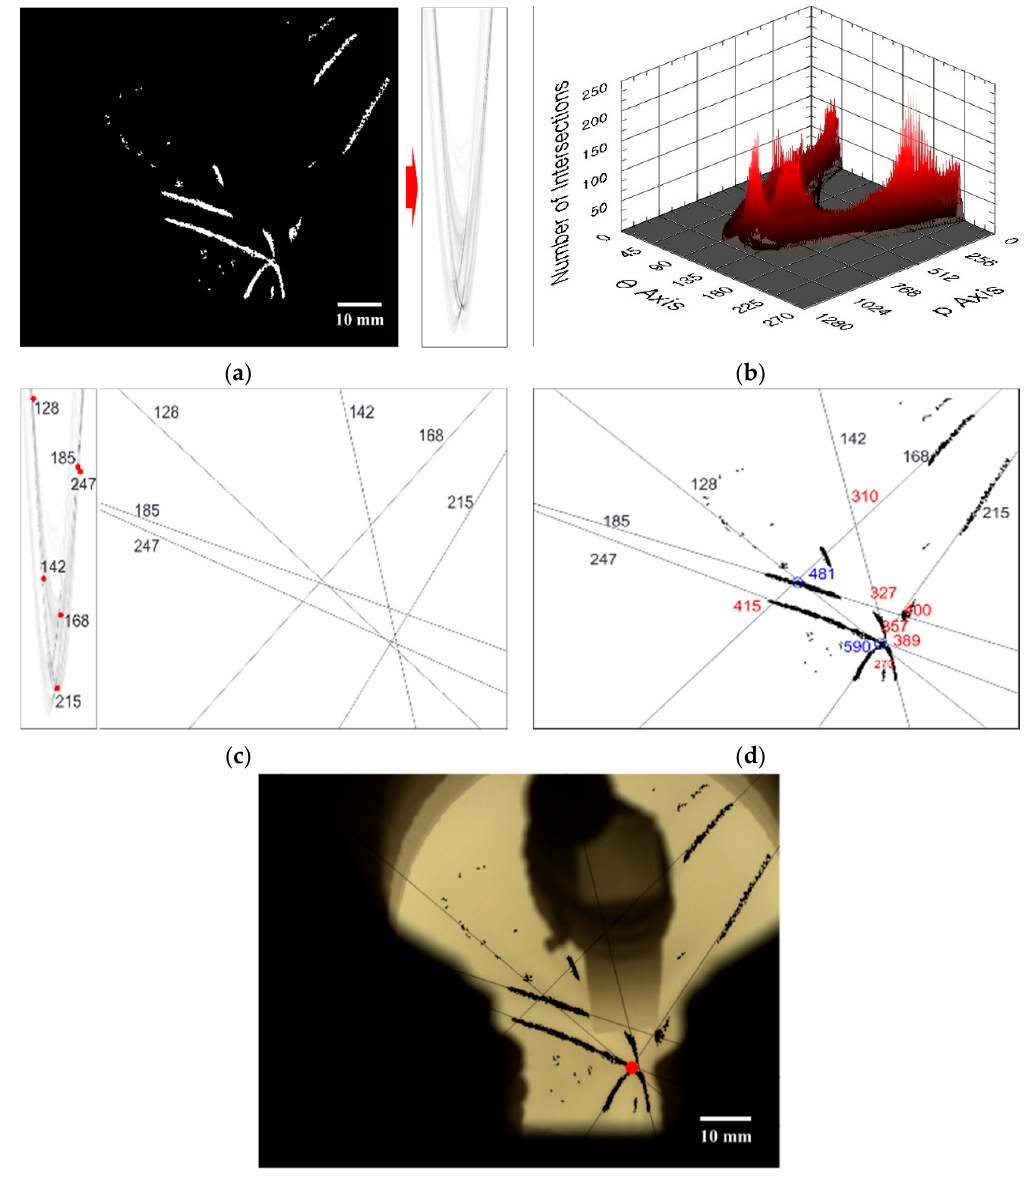
Figure 6. Image processing algorithm for detecting the island center point: ( a ) Hough transform; ( b ) intersection histogram; ( c ) straight line generation on x - y ; ( d ) detection of central point; ( e ) detection of island center point from the original image.